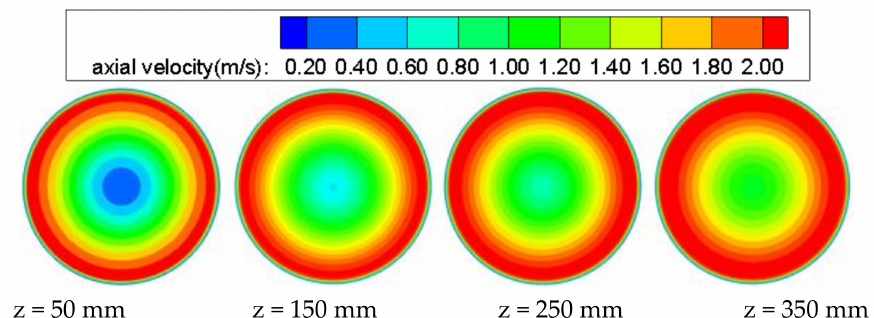
Figure 7. Distribution cloud of axial velocity in different cross sections.